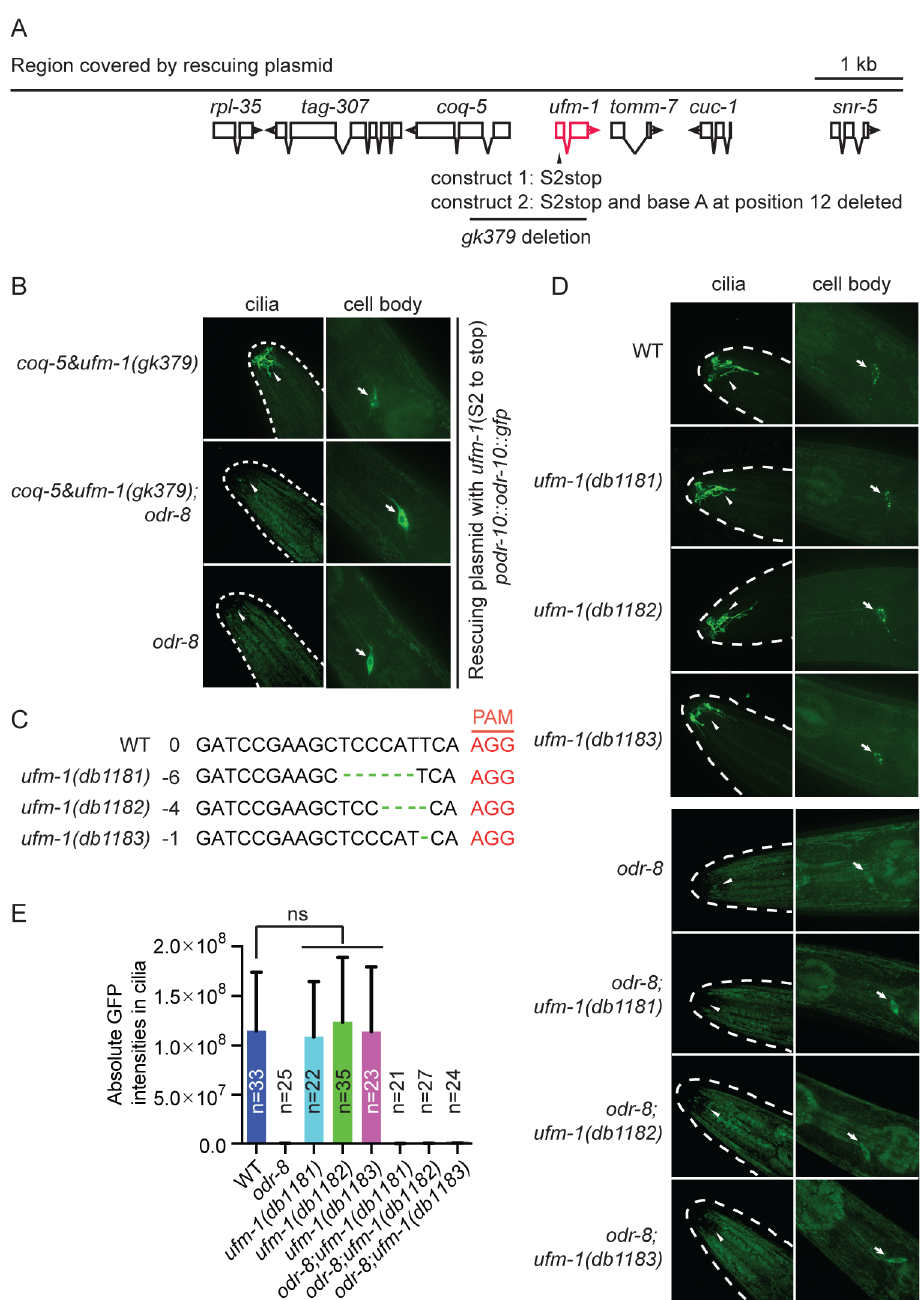
Figure 6. Deleting ufm-1 does not alter ODR-10 localization. (A) Molecular nature of ufm-1(gk379) deletion allele. The gk379 deletion disrupts two adjacent operons – one comprising ufm-1 and tomm-7 and one including coq-5 and tag-307 . gk379 homozygous animals die as embryos or young larvae. To score the ODR-10-GFP localization in adult animals lacking ufm-1 we rescued the gk379 lethal phenotype using a 9 kb genomic fragment in which the ufm-1 open reading frame is interrupted by a stop codon or by a combination of a stop codon and a frameshift mutation, as indicated. (B) Disrupting ufm-1 does not change the ODR-10-GFP phenotype either in wild type animals or odr-8(ky31) mutants. (C) Mutations generated by CRISPR-Cas in the ufm-1 gene. PAM refers to the protospacer adjacent motif. (D–E) Mutations in ufm-1 do not block ODR-10 trafficking to AWA cilia in wild type animals, or rescue the ODR-10 localization defect in an odr-8 mutant background. The ODR-10 cilia localization in (D) was quantified in (E). human orthologs also interacted biochemically. Immunoprecipita- Immunofluorescence studies localized the site of these interac- tion of hODR4-FLAG brought with it HA-UfSP2 (Figure 8C), tions to the ER. Here, we found that ODR-4 co-localized with the suggesting that like the C. elegans proteins, the human orthologs can ER resident protein TRAP a (Figure 8D). By contrast, ODR-8 was form a complex in human cells. diffusely cytosolic when expressed alone, but somewhat reticular